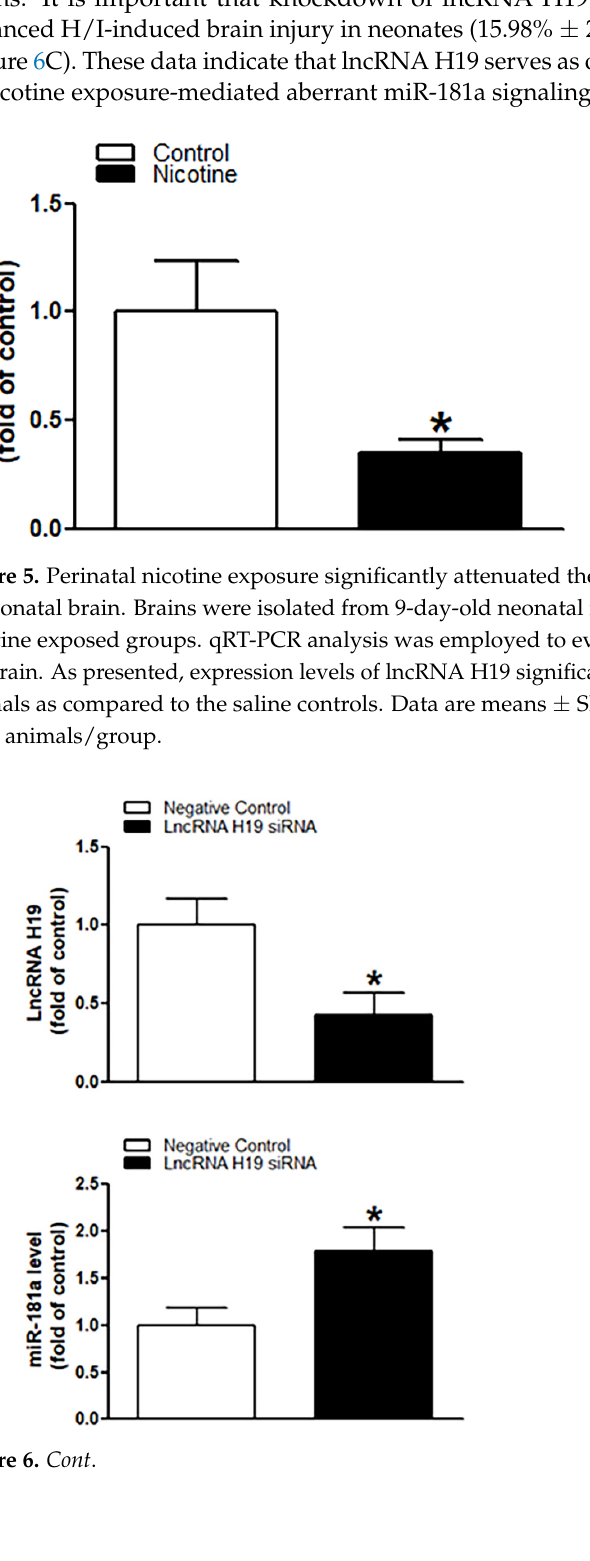
Figure 6. Inhibition of lncRNA H19 upregulated miR-181a expression and enhanced H/I-induced brain injury in neonatal pups. lncRNA H19 siRNA and negative control were administered intrac- erebroventricularly (i.c.v.) on postnatal day 7 (P7) pups, and H/I procedure was conducted on P9 pups. Levels of lncRNA H19 ( A ) and miR-181a ( B ) were evaluated by qRT-PCR analysis in neonatal rat brain on P9 pups. LncRNA H19 siRNA administration not only reduced expression levels of lncRNA H19 but also significantly enhanced expression of miR-181a in neonatal rat brains ( A , B ). Of importance, knockdown of lncRNA H19 also increased H/I-induced brain infarct size as compared to the negative control group ( C ). Data are means ± SEM. * p < 0.05, control vs. lncRNA H19 siRNA. n = 5 animals/group. Brain infarct size ( C ) was determined by TTC staining 48 h after H/I procedure. Data are means ± SEM. * p < 0.05, control vs. lncRNA H19 siRNA. n = 9–11 animals/group. 3. Discussion Emerging evidence reveals the critical roles of non-coding RNAs in brain develop- ment and pathologies. Our present study further enriched this notion. There are several